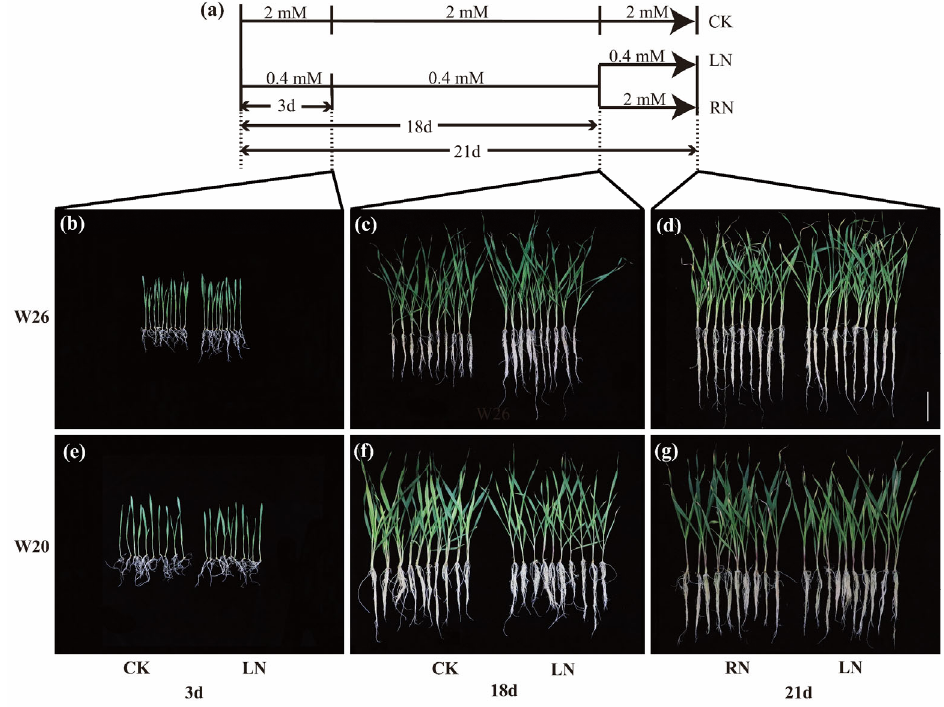
Figure 1. The experimental treatment and the growth of barley at different sampling times. CK represents normal nitrogen, LN represents low nitrogen, and RN represents nitrogen resupply after low nitrogen stress. ( a ) Schematic diagram of different treatments in the experiment. ( b – d ) Growth charts of W26 on the 3rd, 18th, and 21st days. ( e – g ) Growth charts of W26 on the 3rd, 18th, and 21st days. The segment at the lower right corner is the scale of the six drawings, representing the length of 10 cm.